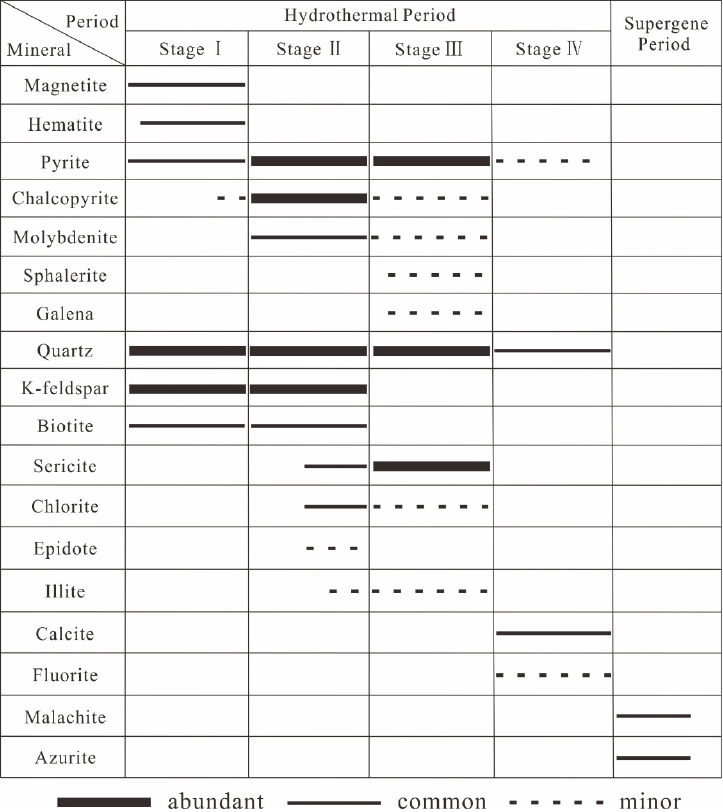
Figure 4. Paragenetic sequence of the major minerals in the Huoluotai Cu (Mo)